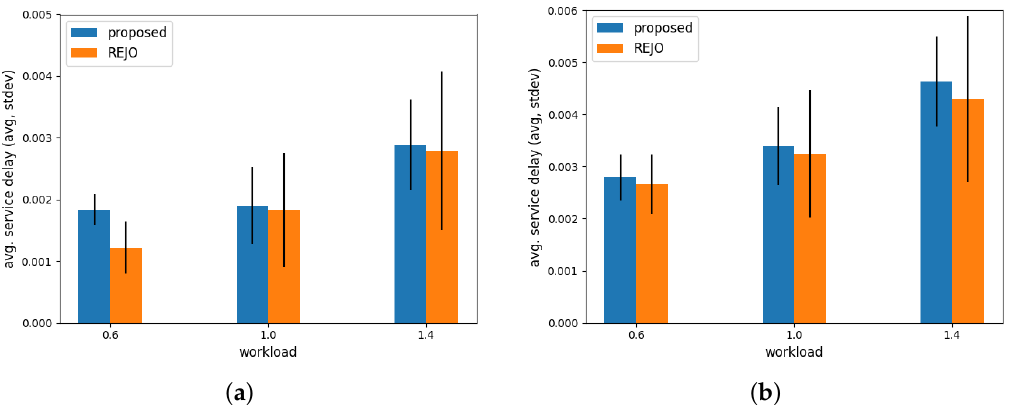
Figure 4. Comparison of service delays. ( a ) 10 MECSs; ( b ) 20